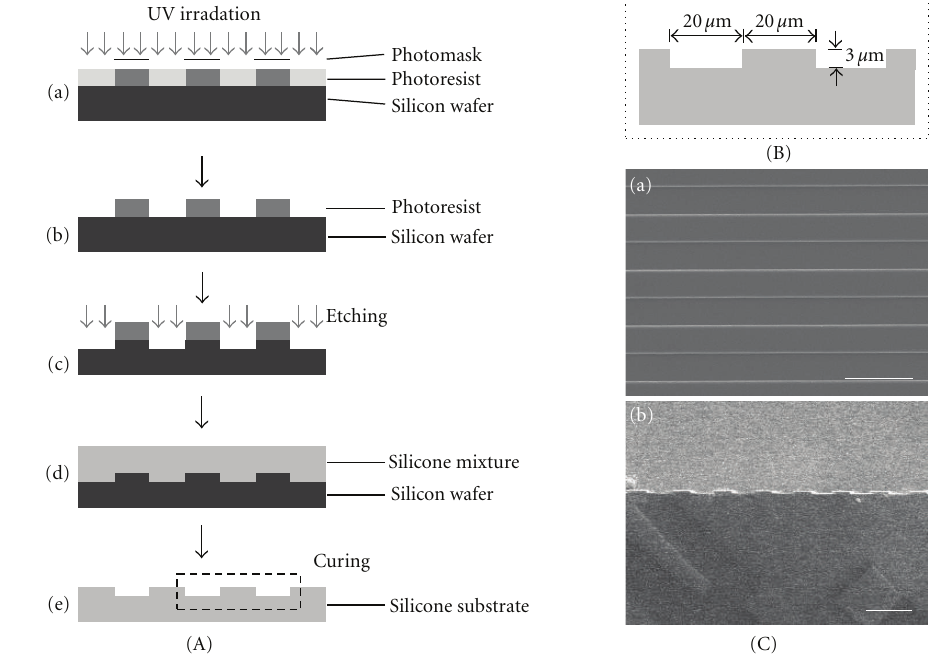
Figure 1: Fabrication of microgrooved substrates. (A) Procedure of fabrication of microgrooved substrates: (a) the negative photoresist was spin-coated onto a silicon wafer, exposed to UV, and polymerased selectively through photomask. (b) The unpolymerased photoresist was washed out. (c) A silicon wafer was etched through the process of DRIE. (d) Silicone mixture was poured onto the microgrooved silicon wafer, spin-coated, and cured at 125 ◦ C for 20 min. (e) The microgrooved substrate was separated from the silicon wafer. (B) The dimensions of each groove were confirmed to be 20 μ m and 3 μ m for width and depth, respectively. (C) SEM images of microgrooved substrates: (a) top view and (b) cross section. (scale bar = 50 μ